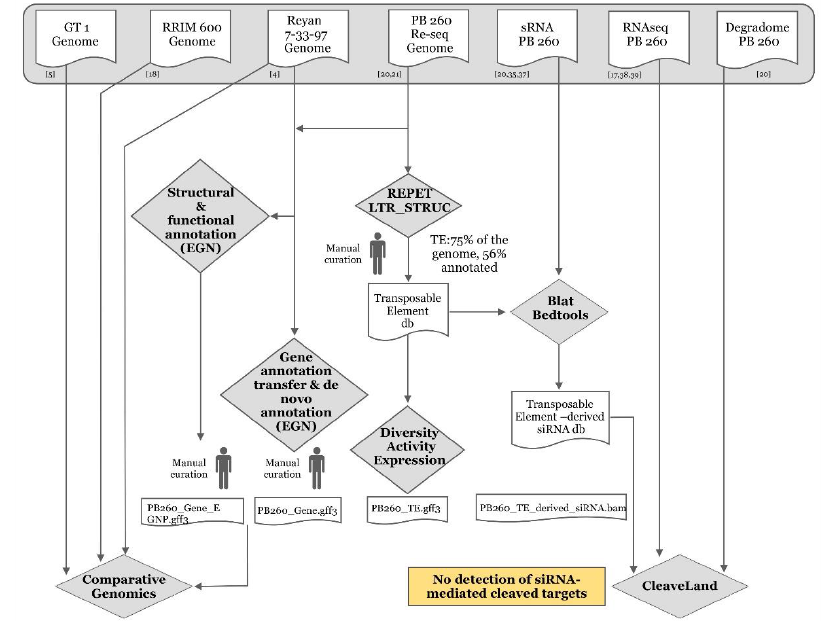
Figure 1. Diagram of the bioinformatics analyses described in this study, and data origins. Numbers